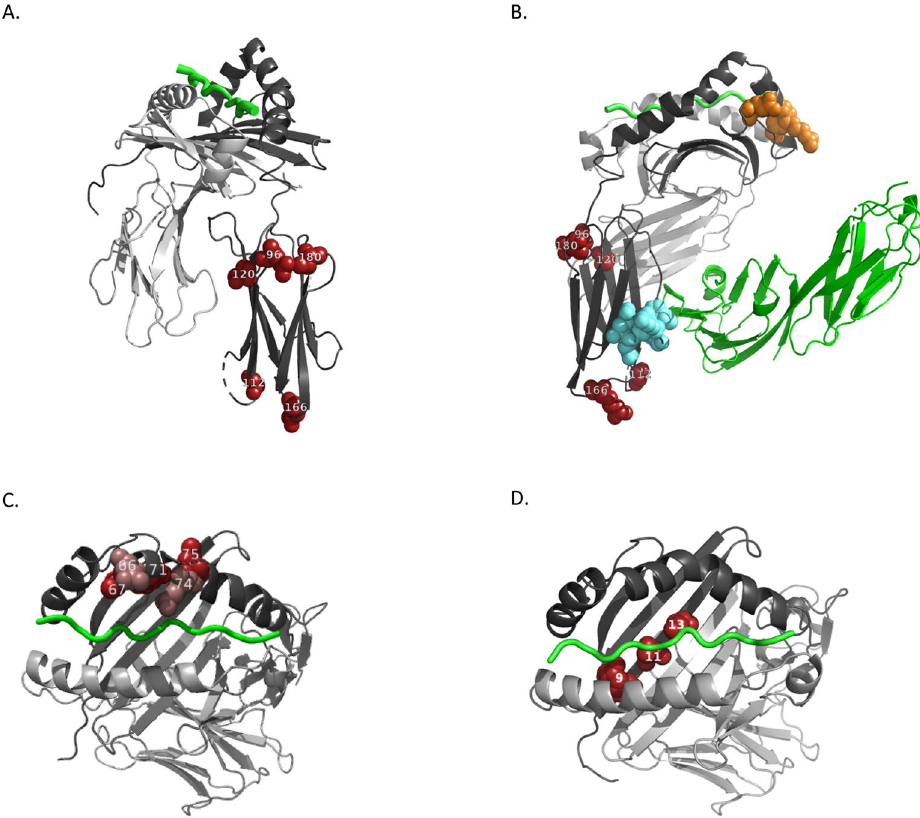
Figure 3. Mapping of index non-synonymous variants and their proxies to structural models of DR1 and DQ1. ( A ) ADA positive status on DR1. Index non-synonymous variant at DRB1 residue 120 and its proxies at residues 96, 112, 166, and 180 shown as red spheres are mapped onto the crystal structure of DR1 (PDB ID: 3S4S) 27 . DRA1 and DRB1 peptides are represented in light and dark gray ribbons, respectively. A 13 residue peptide in the peptide-binding grove is indicated by a green coil. The index variant and its proxies map to the β2 beta- sandwich domain of DRB1. ( B ) ADA positive status on DR1 with CD4. Same representation of the DRB1 index variant 96 and its proxies as in ( A ), but now including CD4, making contact with the β2 beta-sandwich domain of DRB1. Also shown are residues in DRB1 inferred from mutagenesis to interfere with CD4-mediated T-cell response from Brogdon et al. (residues, 46, 54, 55, 56, orange spheres) 34 and Konig et al. (residues, 137–143, cyan spheres) 33 . ( C ) ADA maximum titer top 10% and NAb positive status on DQ1. Index non-synonymous variant at DQB1 residue 71 and its proxies at residues 66, 67, 74, and 75 are mapped onto the crystal structure of DQ1 (PDB ID: 6DIG) 26 , and represented as spheres alternating in darker and lighter red to aid visualization. DRA1 and DRB1 peptides are represented in light and dark gray ribbons, respectively. A 13 residue peptide in the peptide-binding grove is indicated by a green coil. ( D ) ADA maximum titer on DR1. Index non- synonymous variant at residue 13 and its proxies at residues 9 and 11 are mapped onto the crystal structure of DR1 (PDB ID: 6CQN) 25 , and represented as red spheres. DRA1 and DRB1 peptides are represented in light and dark gray ribbons, respectively. A 13 residue peptide in the peptide-binding grove is indicated by a green